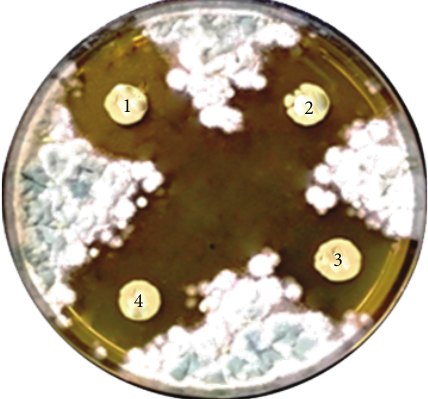
Figure 1: Antifungal activity of L. plantarum against A.